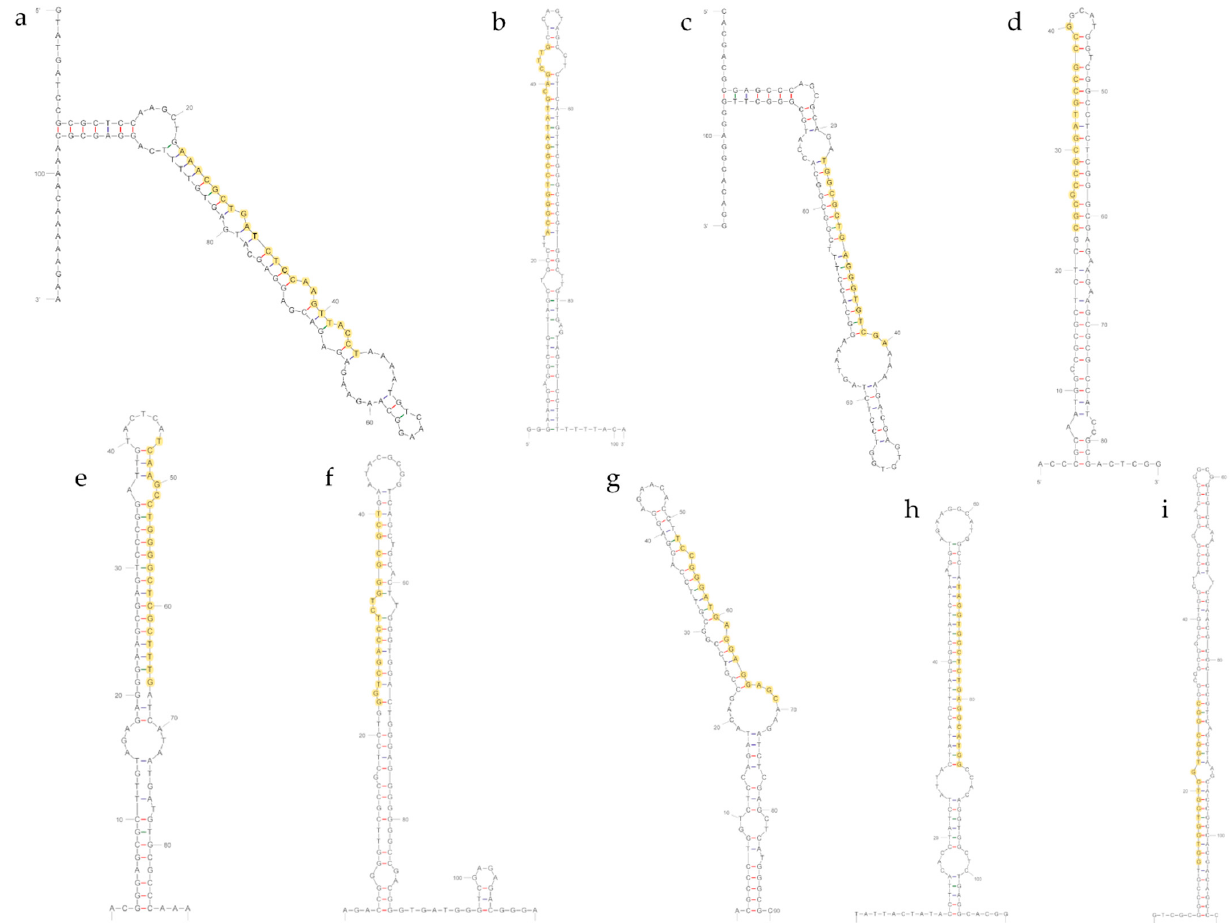
Figure 1. Prediction of the V. nonalfalfae precursor secondary structures; ( a )—vna-miR-1, ( b )—vna-miR-2, ( c )—vna-miR-3, ( d )—vna-miR-4, ( e )—vna-miR-5, ( f )—vna-miR-6, ( g )—vna-miR-7, ( h )—vna-miR-8 and ( i )—conserved-miR-7044; the mature milRNA sequence is highlighted in yellow. 2.3. Stem-Loop RT-qPCR Validation and Expression Analysis of Verticillium nonalfalfae